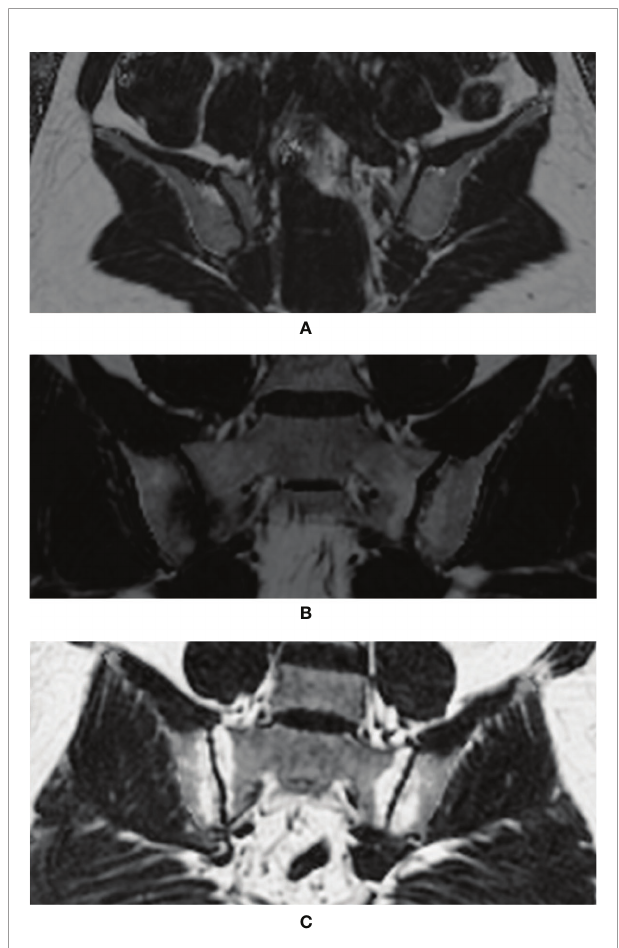
FIGURE 2 | Examples of typical fat deposition patterns in different diagnostic groups. (A) Healthy volunteers with regional hot spots of fat deposition in the SIJ (B) SpA patients with simultaneous fat deposition and bone marrow edema in the SIJ (C) axSpA patients with fat deposition diffusely distributed in the subchondral area in the SIJ (SpA, spondyloarthritis; axSpA, axial spondyloarthritis; SIJ, sacroiliac